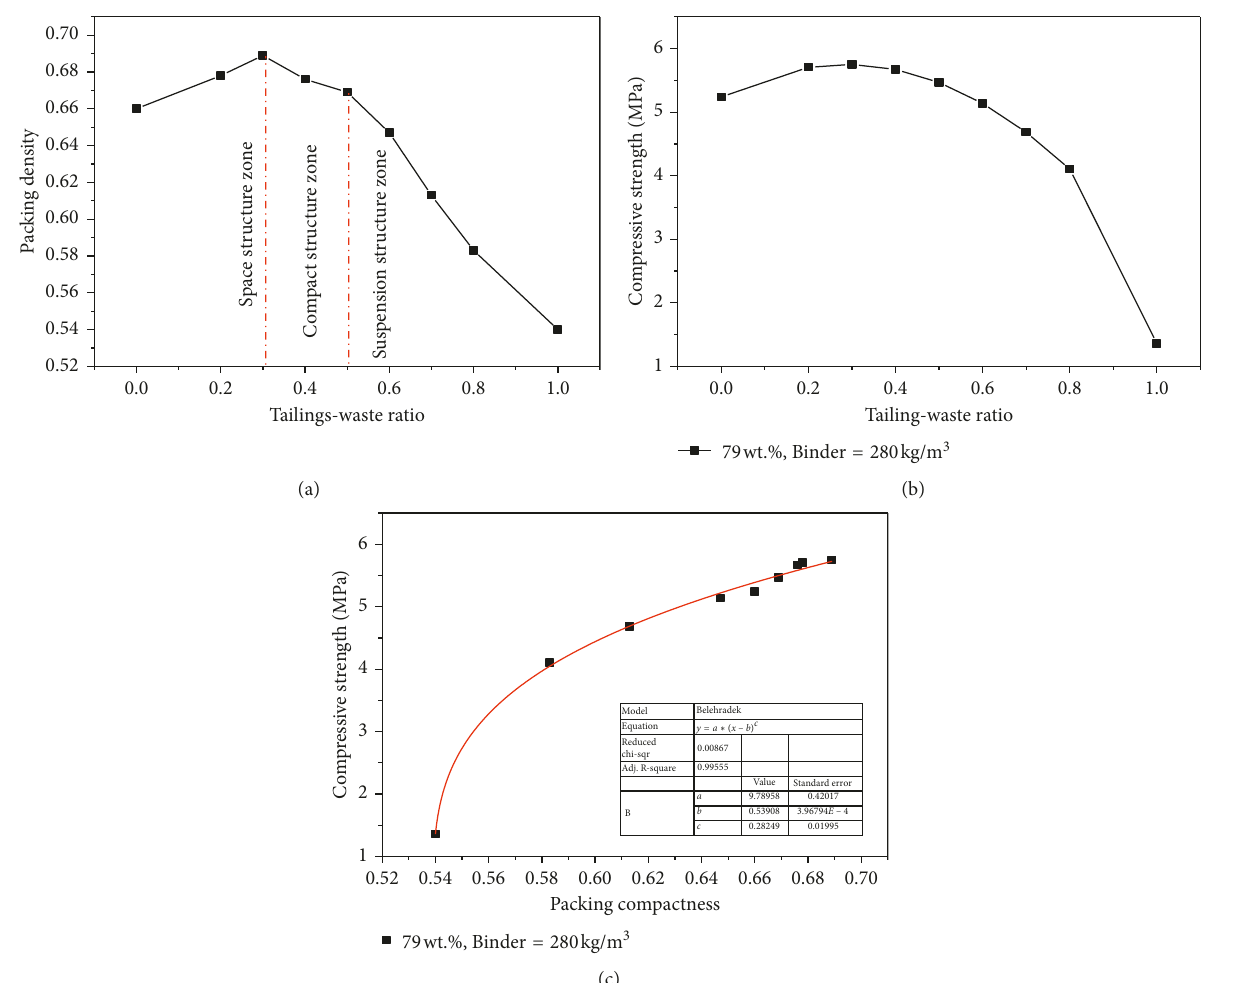
Figure 6: Packing-density analysis. (a) Relationship between tailings-waste ratio and packing density. (b) Tailings-waste ratio and the strength in the 28th day. (c) Relationship between density and strength.